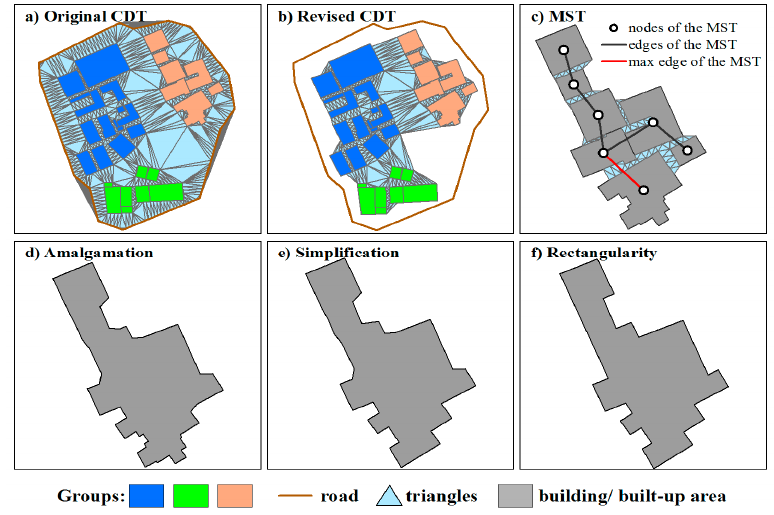
Figure 3. An example of the amalgamation process for ( a ) a constrained Delaunay triangulation (CDT) is constructed for all buildings within a block; ( b ) the revised constrained